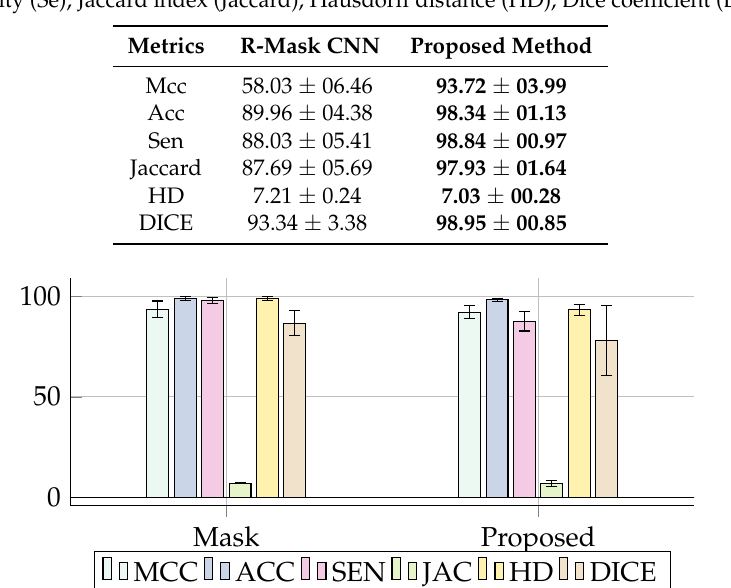
Table 2. Metrics of the proposed method, being Matthews Correlation coefficient (Mcc), Accuracy